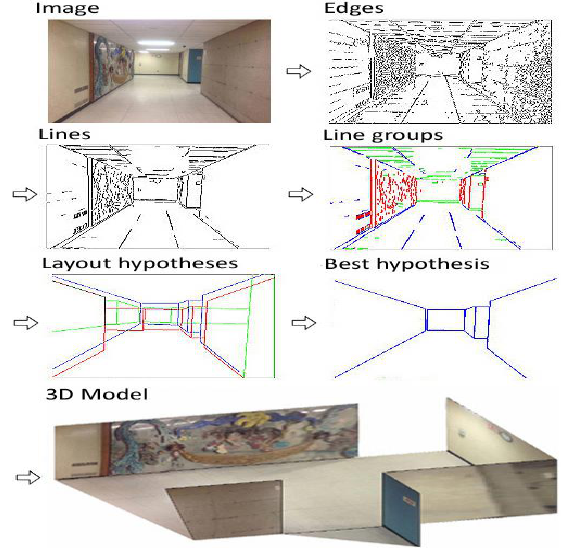
Figure 1. The proposed method detects edges and groups them into lines, and then line groups. It makes layout hypotheses using vanishing points and scores them using a linear scoring function, and finally converts the best hypothesis into